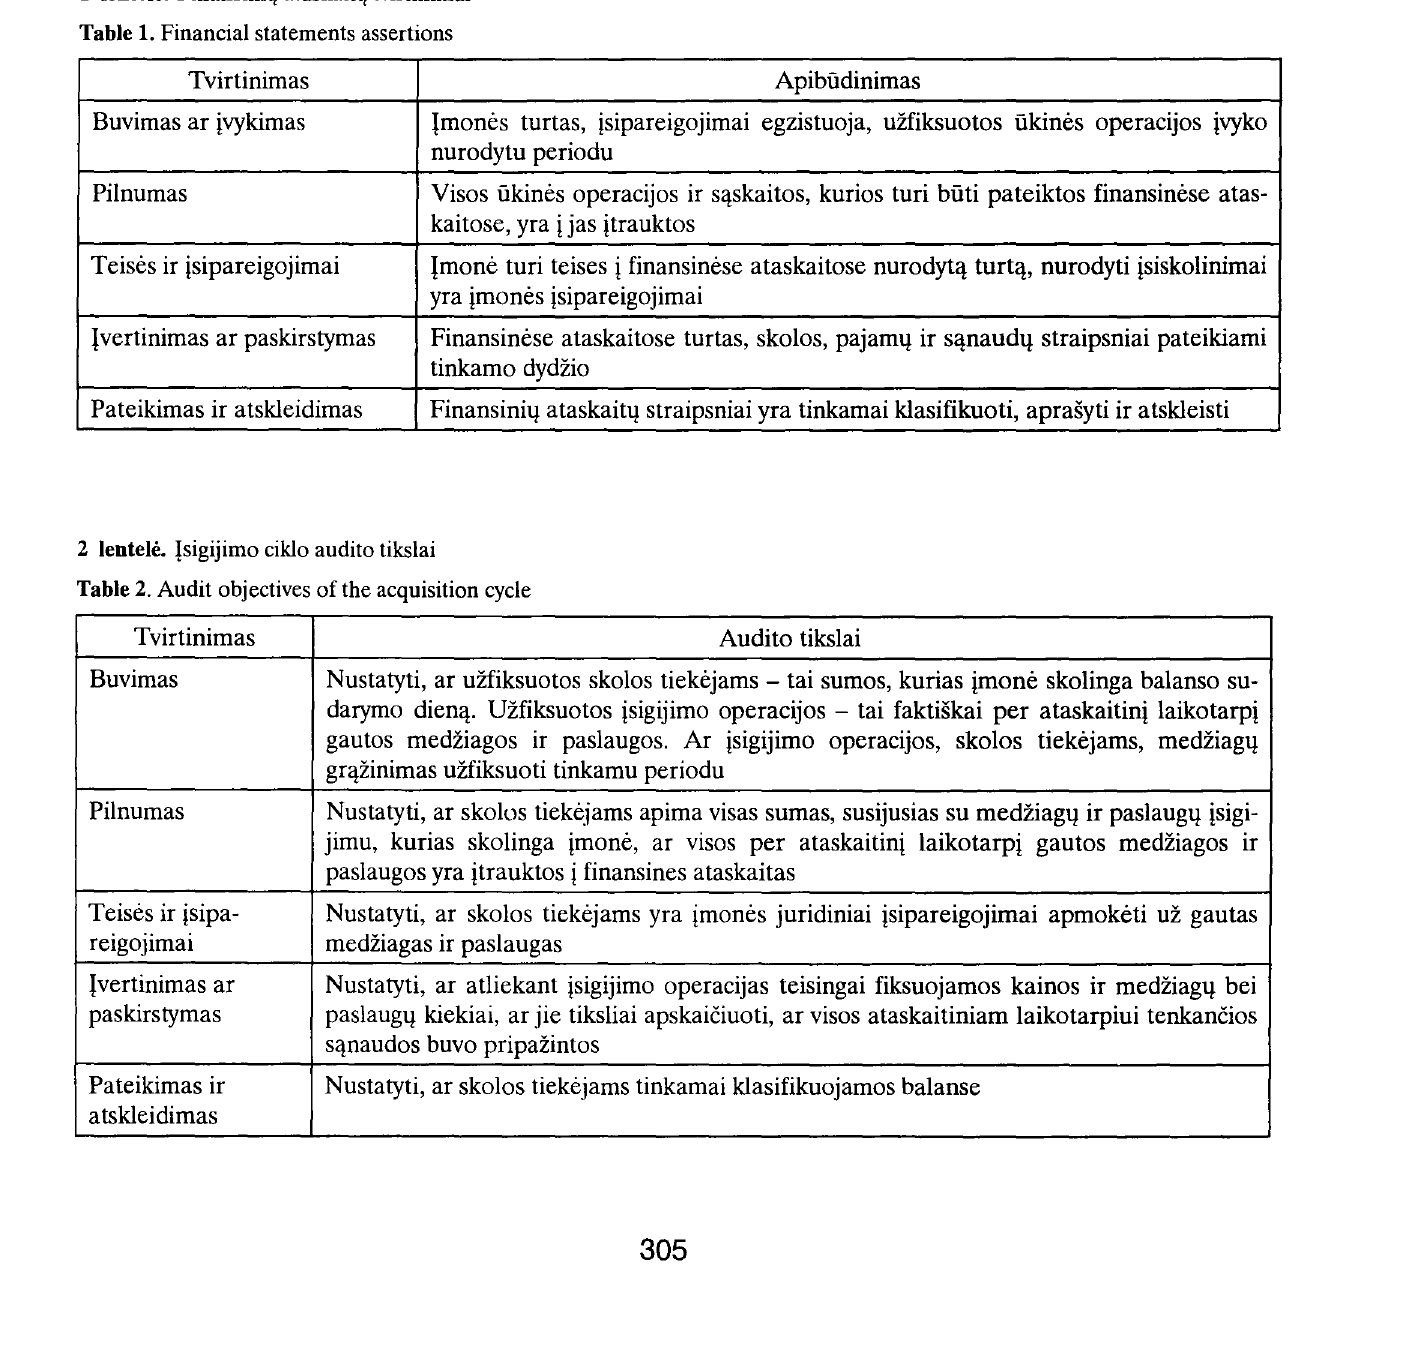
Table 2. Audit objectives of the acquisition cycle